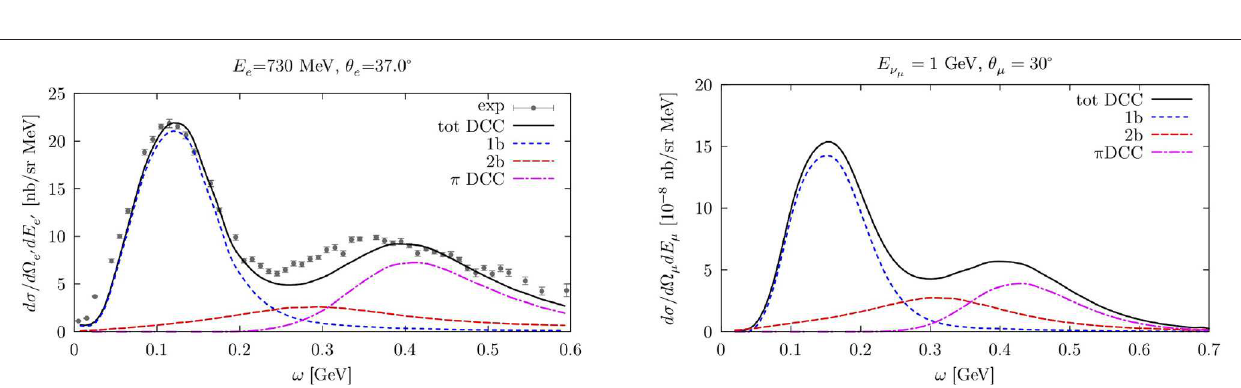
FIGURE 8 | (Left) Inclusive 12 C( e , e ’) cross sections at 620 MeV and 36 ◦ scattering angle. The solid and dashed curves correspond to the SCGF and CBF SF calculations, respectively. The red lines correspond to the IA calculation in which the outgoing nucleon is free while in the blue ones FSI corrections have been taken into account. (Right) Inclusive Ar( e , e ’) cross section at 2.2 GeV and 15.5 ◦ scattering angle. The solid (dashed) line shows the quasielastic cross section without (with) the inclusion of FSI obtained utilizing the SCGF spectral function calculations. Experimental data are taken from Dai et al. [104, 105] and show both the quasielastic peak and the contribution from meson production at larger missing energies.